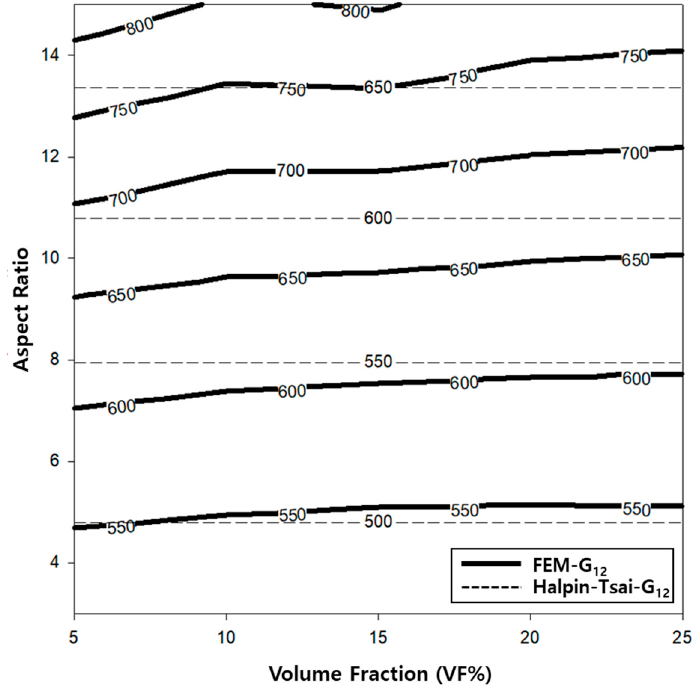
Figure 8. Contour graph showing shear modulus (G 12 ) as functions of the volume fraction and aspect ratio. aspect